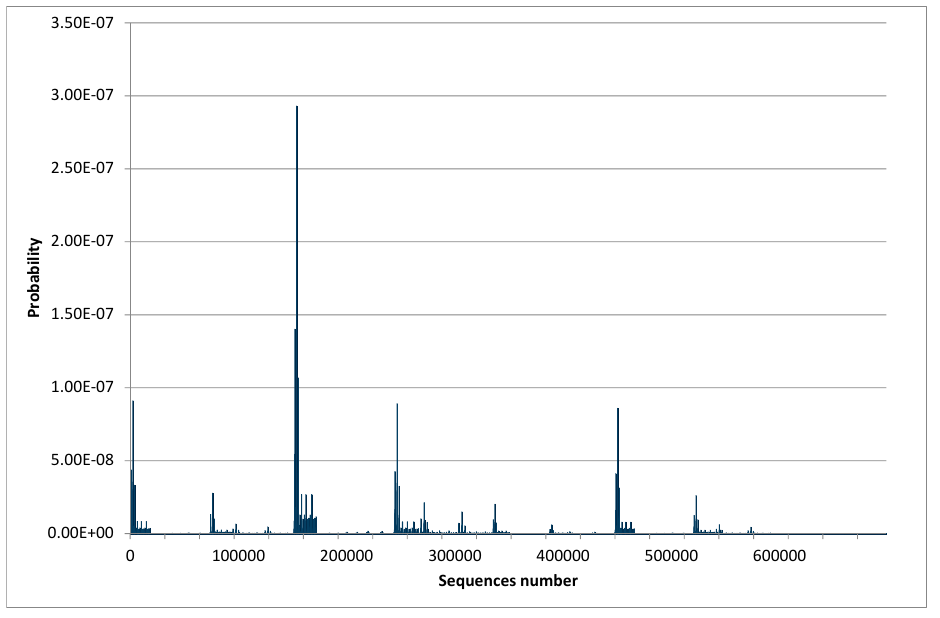
Figure 10. The probability of the sequences of events contain the catalyst sinterization for the fixed-bed based plant.